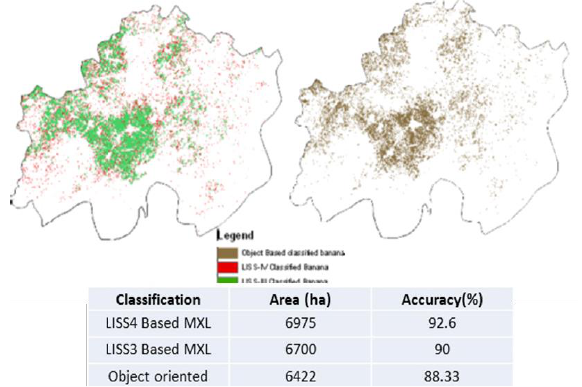
Figure 7. Pixel and object-based classification for banana in Borsad Taluka of Anand district